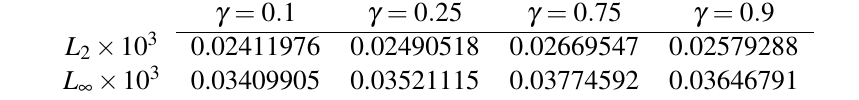
Table 4 The error norms L 2 and L ∞ of Example 1 for N =120, t f = 1 . 0, ∆ t = 0 . 00025 for different values of